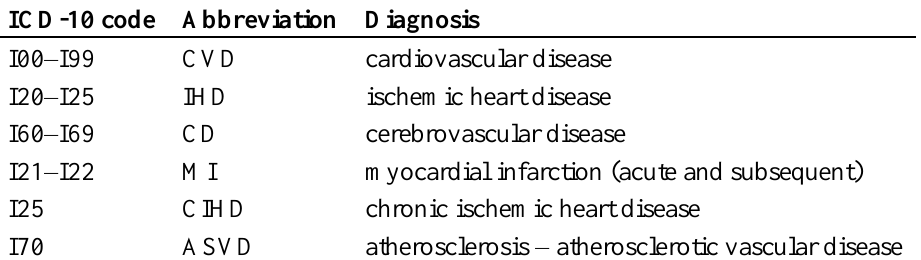
Table 1. Examined diagnoses according to the International Statistical Classification of Diseases (ICD–10) coding and abbreviations